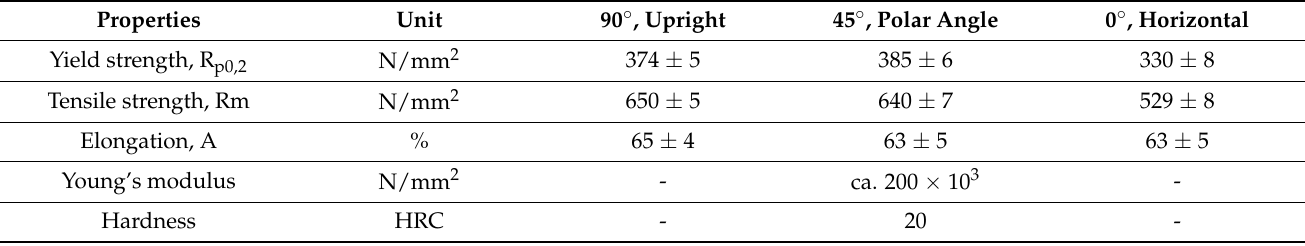
Table 2. Mechanical properties of the 316L steel